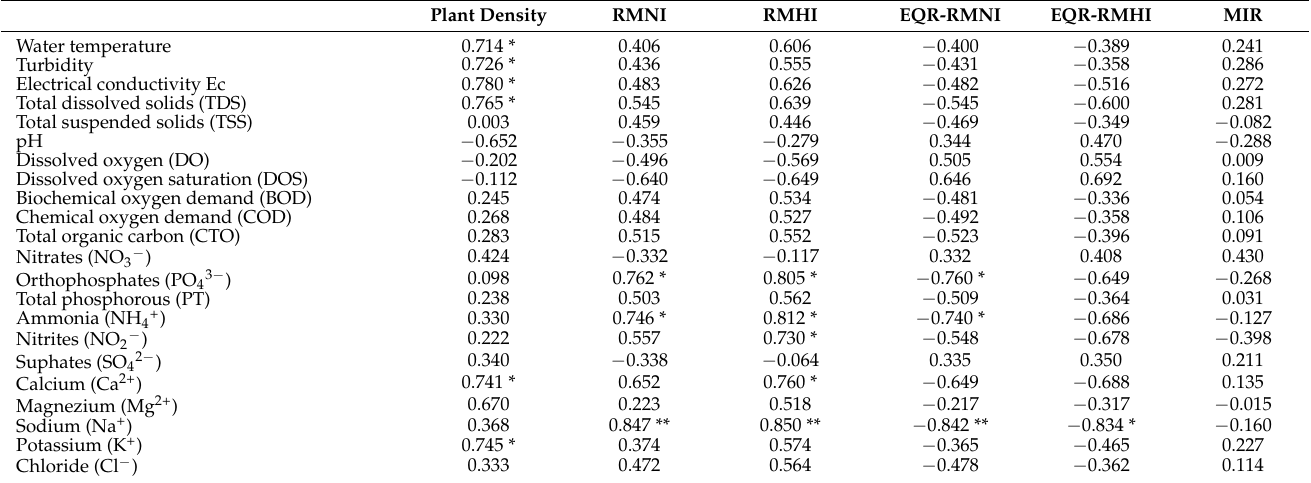
Table 7. Pearson’s correlation between macrophyte indices and physicochemical parameters of water. Plant Density